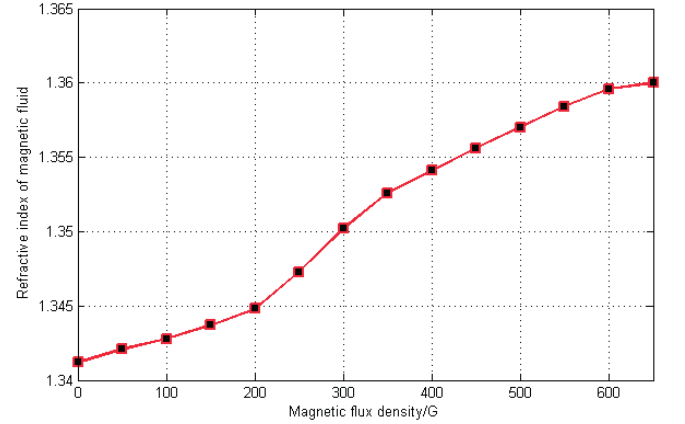
Figure 2. Relationship between the refractive index of magnetic fluid and magnetic flux density.